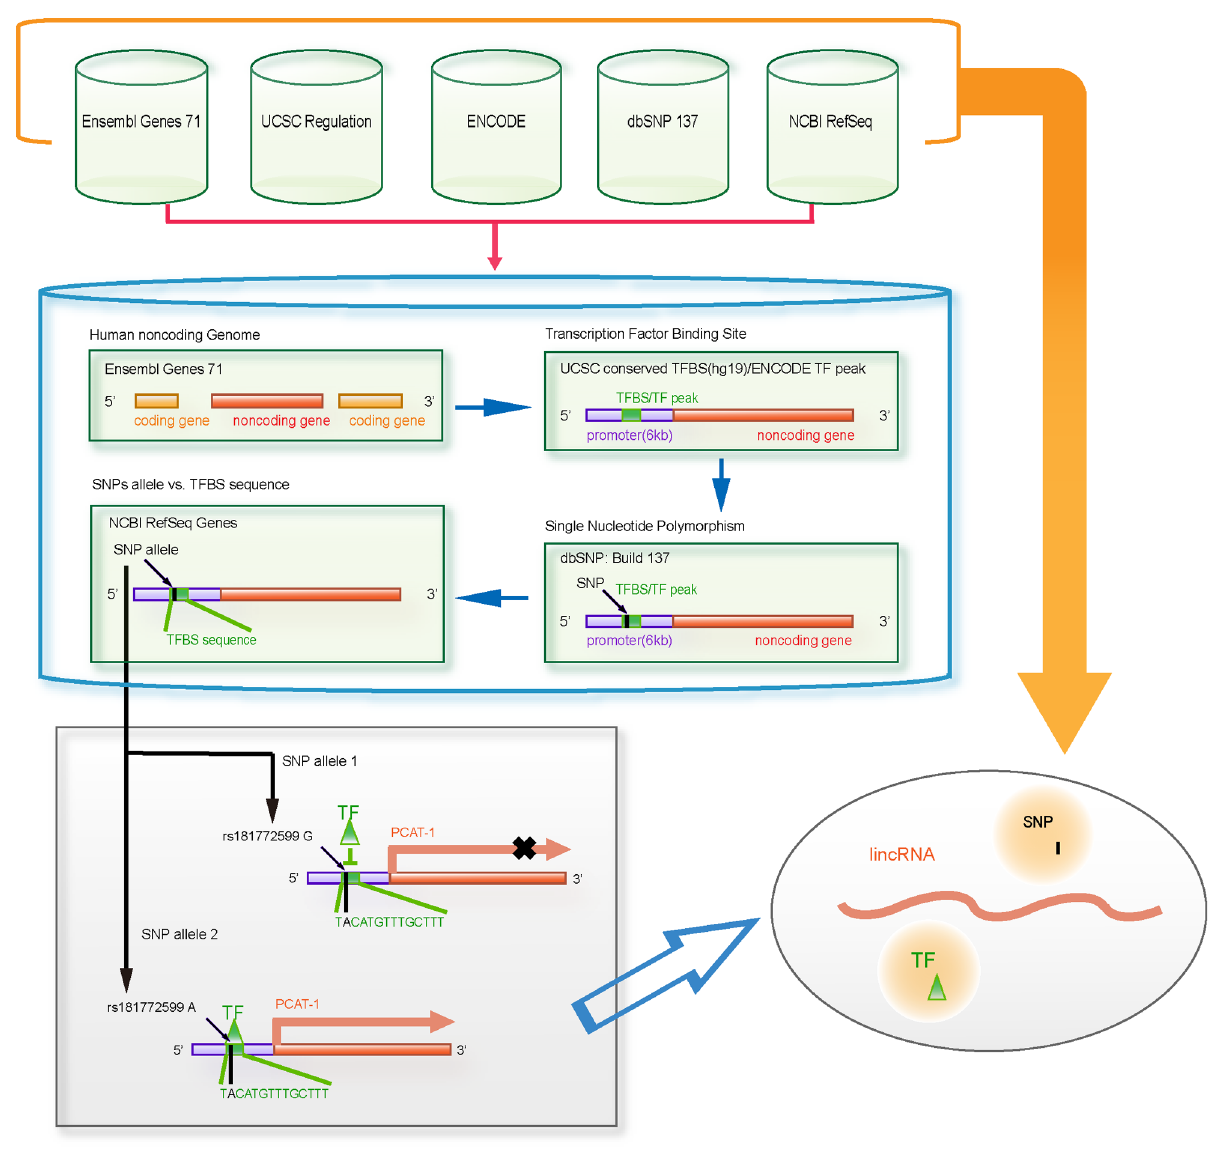
Figure 1. Architecture of SNP@lincTFBS.